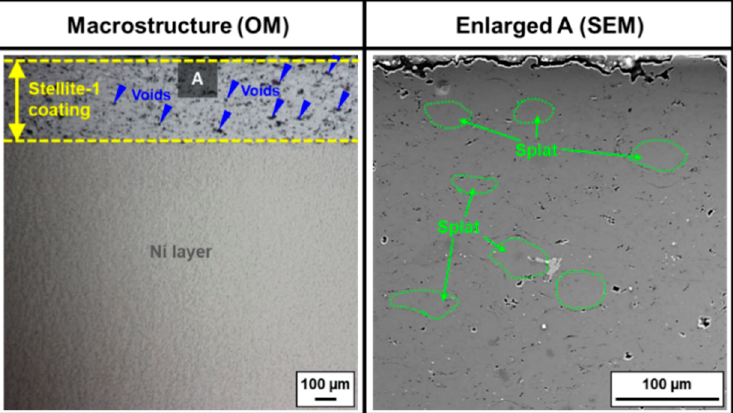
Figure 4. Cross-sectional OM and SEM (backscattered electron mode) micrographs of the as-sprayed Stellite-1 coating.